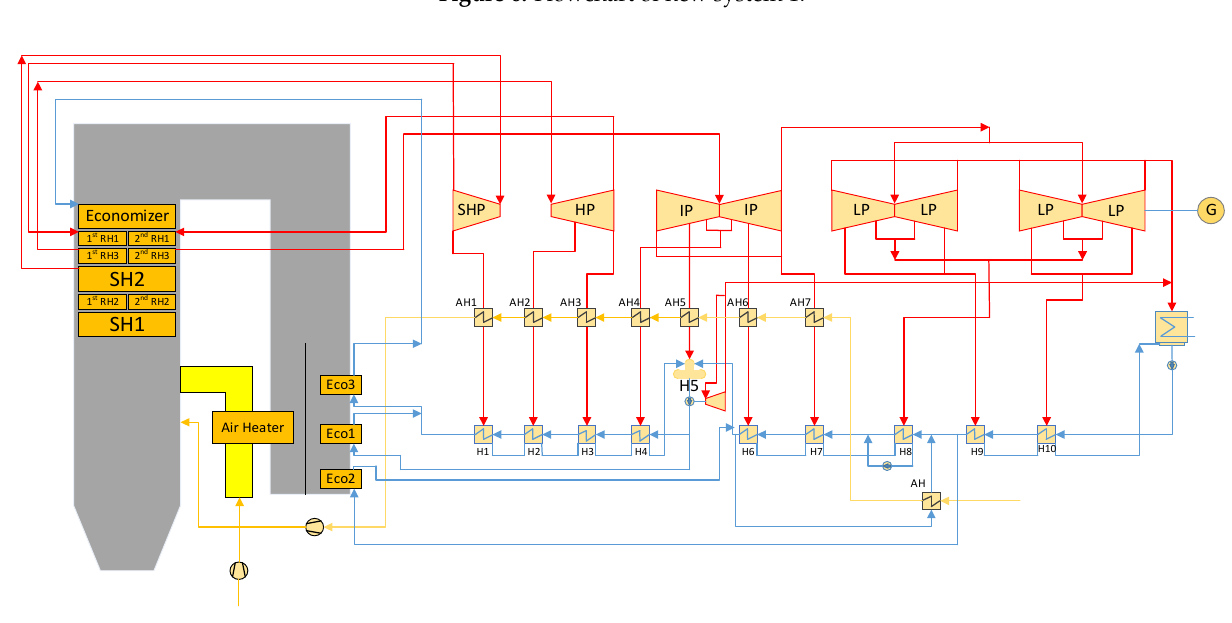
Figure 7. Flowchart of new system 2.